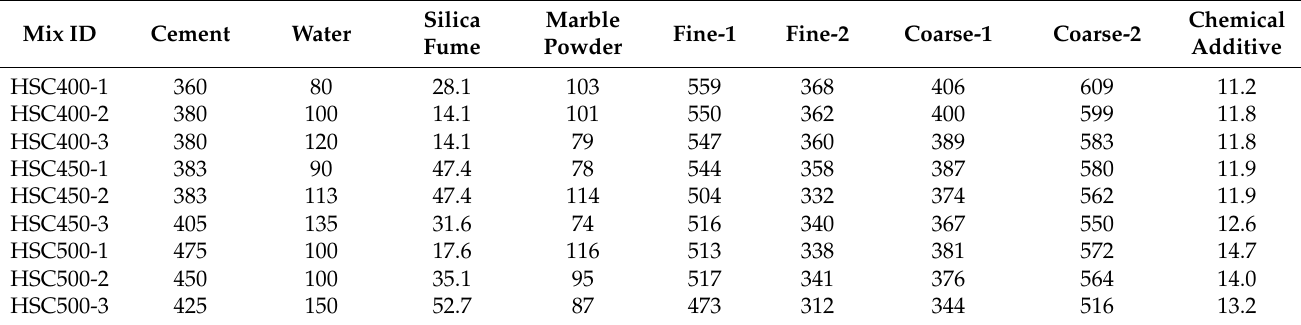
Table 2. Mixture amounts of high-strength